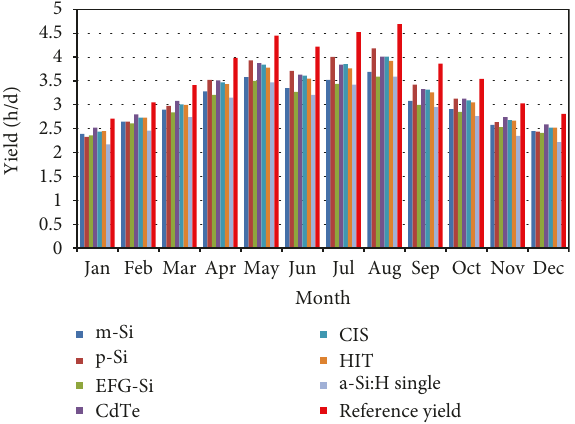
Figure 5: Monthly average array yield of seven PV module technologies compared with the reference yield.